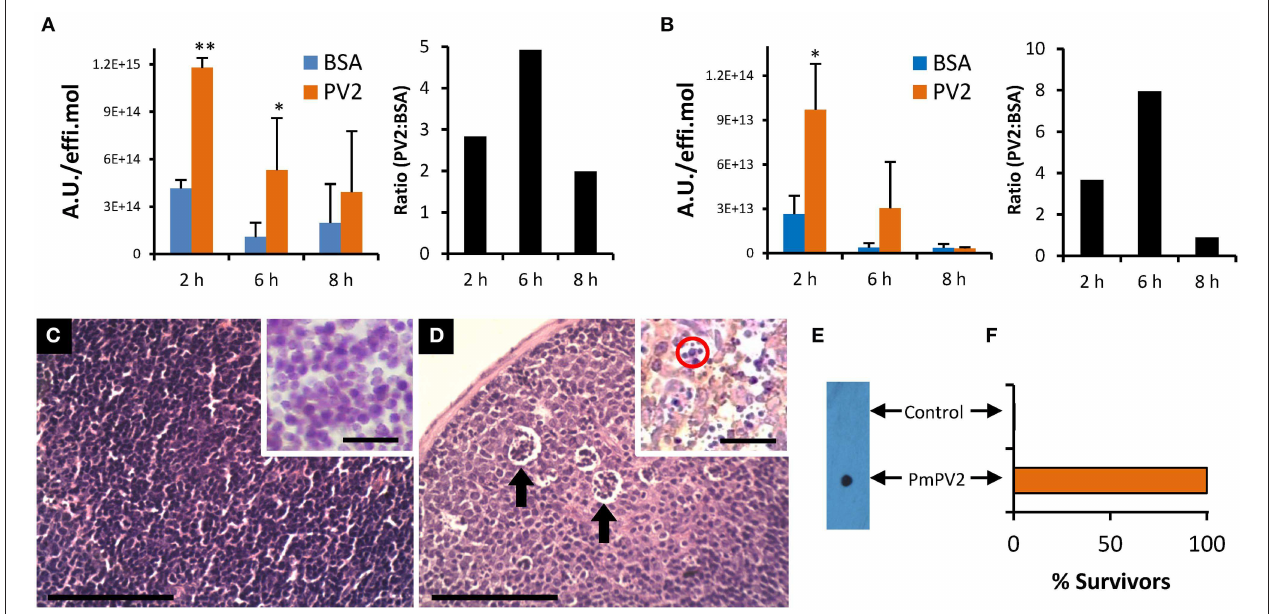
FIGURE 5 | PmPV2 fate, internalization and immune response after oral ingestion in mice. (A,B) Fate and internalization of fluorescently-labeled PmPV2 in mice intestine (A) and Peyer’s patches (B) at different times after ingestion. Results are expressed as the Mean ± SEM of A.U./effi.mol ( n = 3) and are representative of two independent experiments. Right panels : PmPV2:BSA ratio of values from left panel. * P < 0.05; ** P < 0.01. (C,D) Peyer’s patches of control mouse (C) and PmPV2-treated mouse (D) . Cumuli of apoptotic cells are highlighted with arrows. Bar 100 µ m. Insets : IHC using mouse IgG anti-Caspase 3 antibodies (1:200). Mice treated with PmPV2 showed positive reaction; Caspase-3 location appears as yellowish regions. Apoptotic bodies were also evident in treated mice (red circle). Bar 50 µ m. (E,F) Mice oral immunization against PmPV2. (E) Dot blot analysis of sera from mice gavaged with PBS (Control) or with 800 µ g PmPV2 (PmPV2). (F) Effect of lethal (1mg) i.p. dosis of PmPV2 on control and immunized mice survival ( n = 3). Please note graph does not include error bars because all of the three immunized animals survived and all of the three control animals died after the intraperitoneal